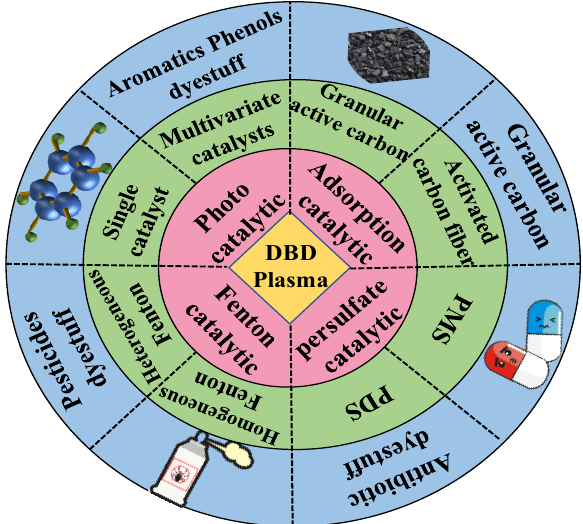
Figure 1. Classification of DBD plasmas coupled to other catalysts.